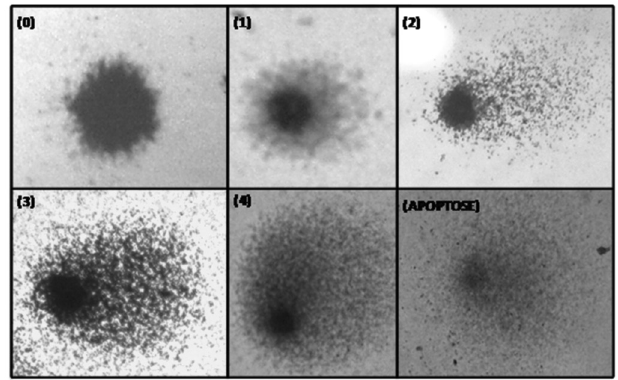
Figura 1. Classificação do Dano ao DNA dos indivíduos analisados. Quanto maior o nível de dano maior o número a ele atribuído. Classe 0 representa células sem dano e classe 4 o mais alto dano.